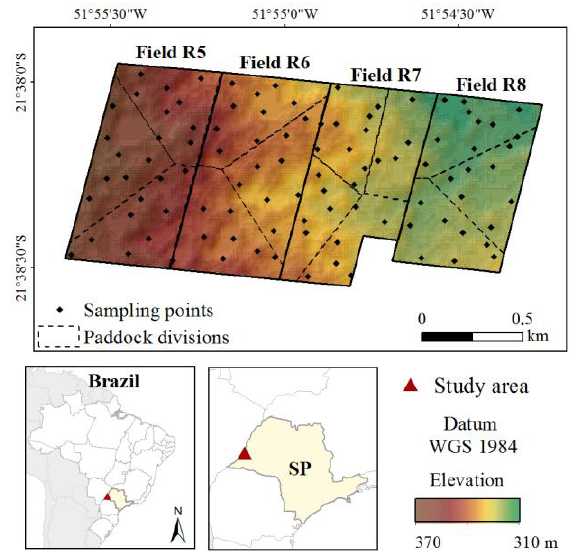
Figure 1. Location of the study area in western region of São Paulo (SP) state, Brazil, and the sampling